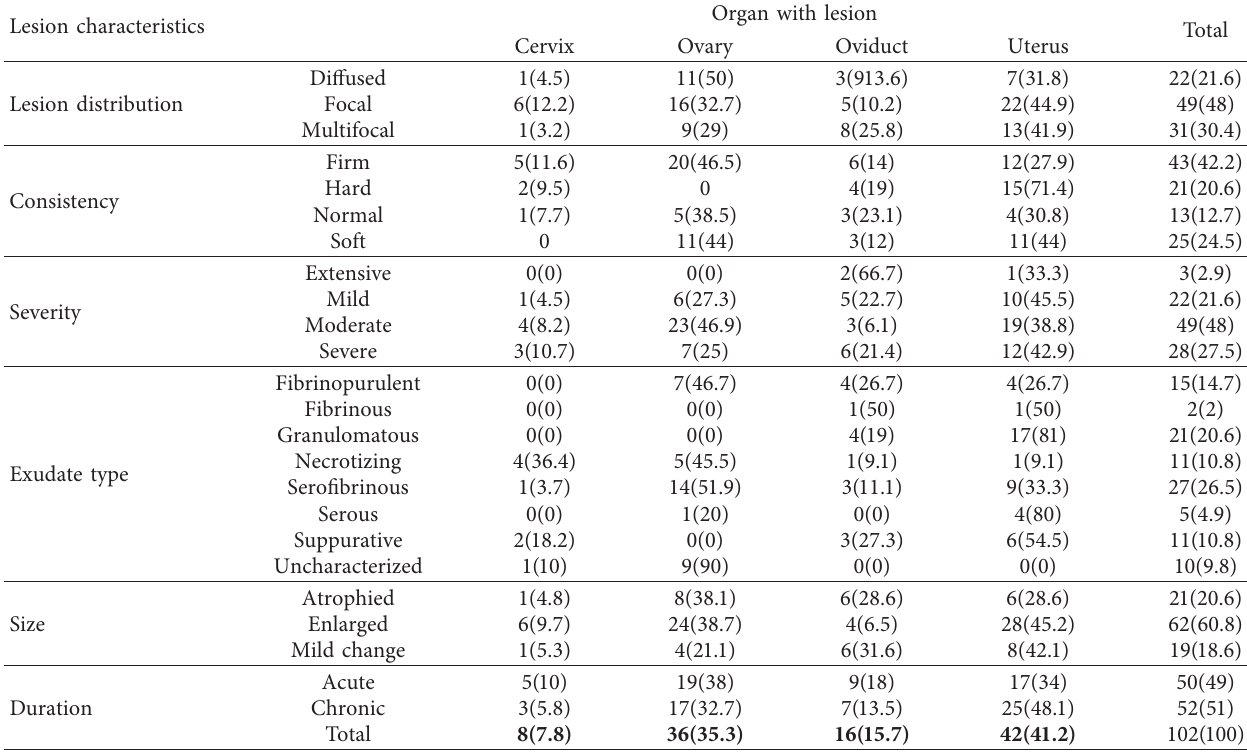
Table 4: Grossly characterized pathological lesion in reproductive organs of she-camels. Lesion